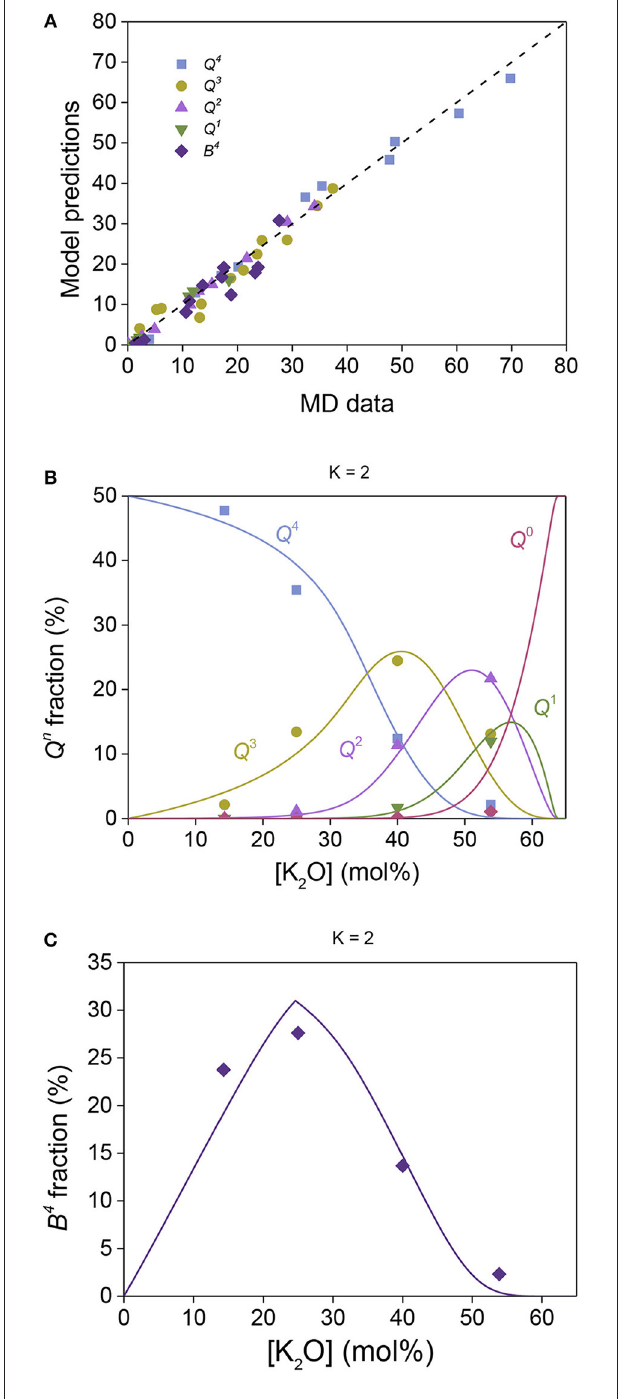
FIGURE 6 | Potassium borosilicate structural data obtained by MD simulations compared to model predictions with zero free parameters. (A) All experimental data plotted against the model predictions, where the dashed line shows the one-to-one correlation. (B) Q n fractions for silicate structural groups (symbols) and model predictions (lines) plotted against the overall modifier concentration for glasses with K = 2. (C) Fraction of four-fold coordinated boron as obtained by MD simulations (symbols) and model predictions (line) plotted against the overall modifier concentration for glasses with K =